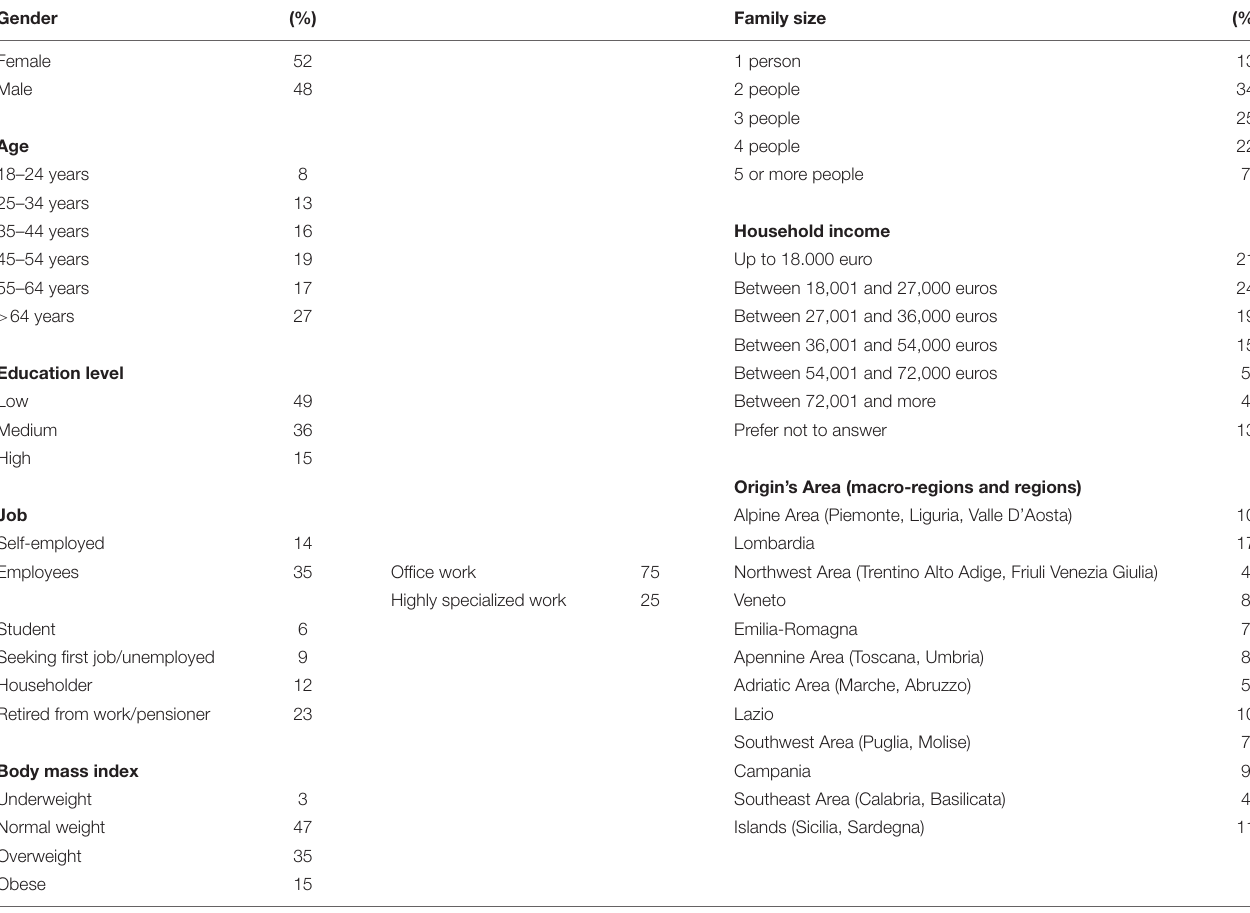
TABLE 1 | Population sociodemographic information and Body Mass Index (BMI).